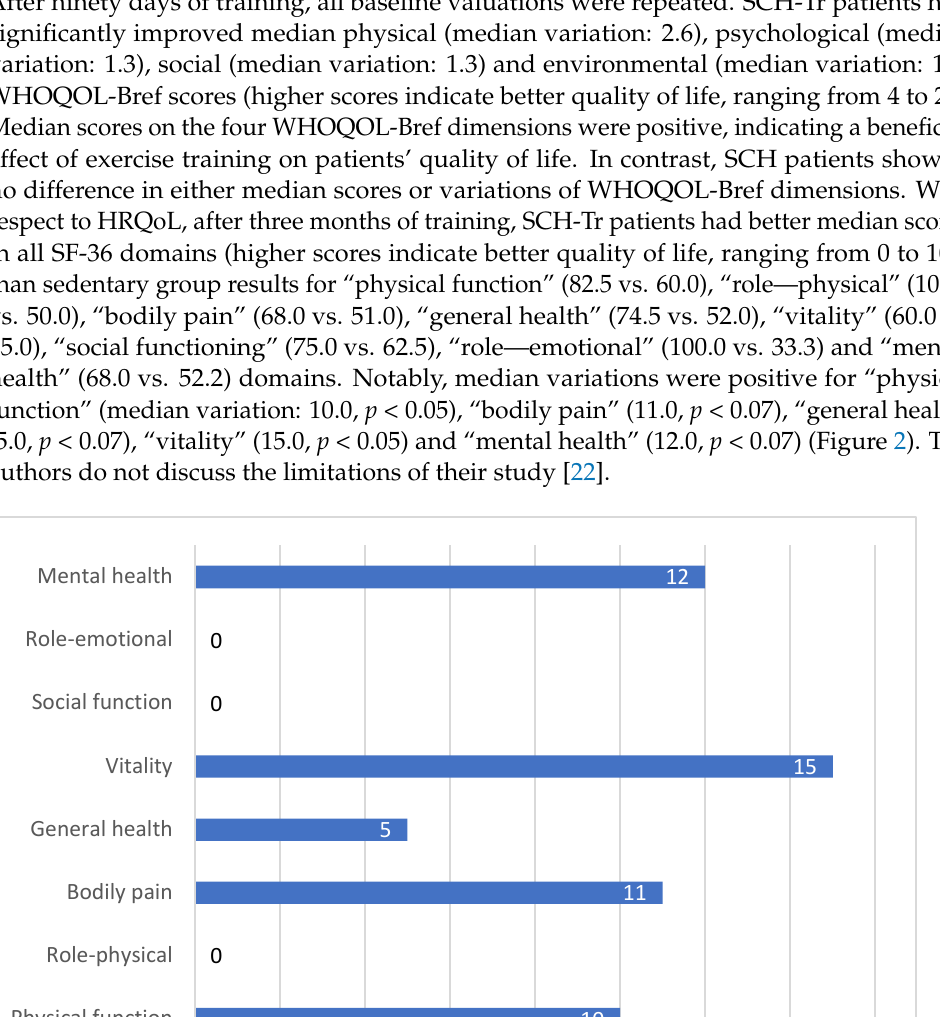
orous, 0 (0–180); moderate, 60 (0–240); and walking, 210 (90–840). Furthermore, in an ex-